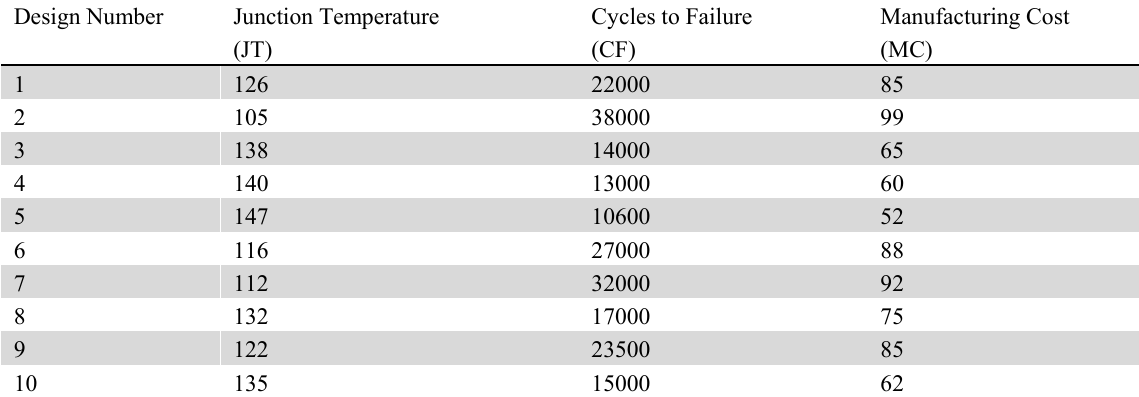
Description of the design alternatives ( Besharati